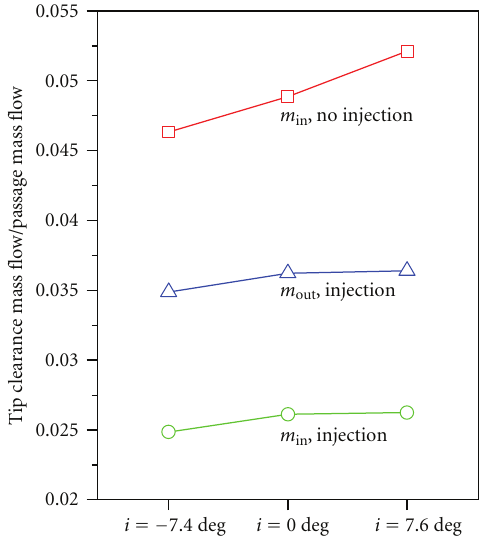
Figure 9: Comparison of tip clearance mass flow at design and o ff - design conditions.